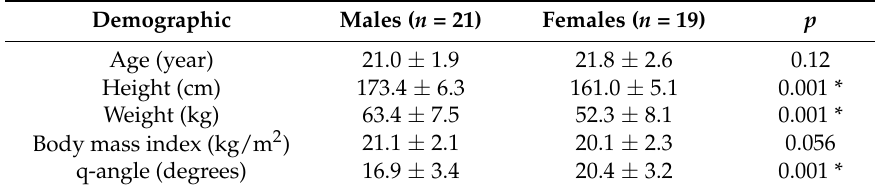
Table 1. Characteristics of the participants